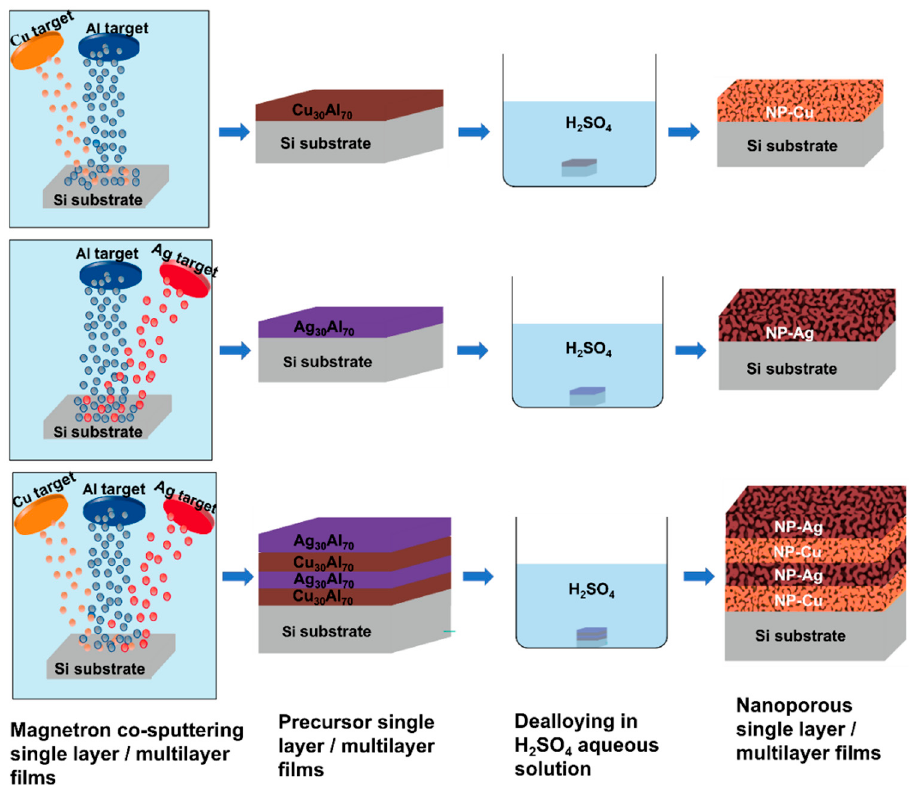
Figure 1. Preparation of precursor films by magnetron co-sputtering and preparation of NP–Cu, NP–Ag thin films and NP–Cu/Ag multilayer films by dealloying in sulfuric acid.